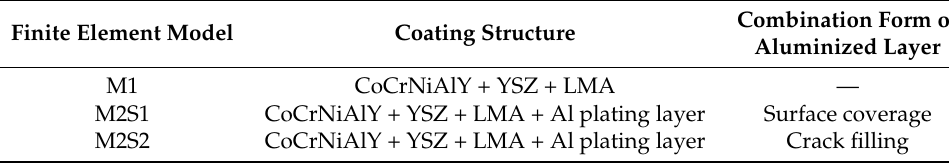
Table 2. The layer structure corresponding to the finite element model.